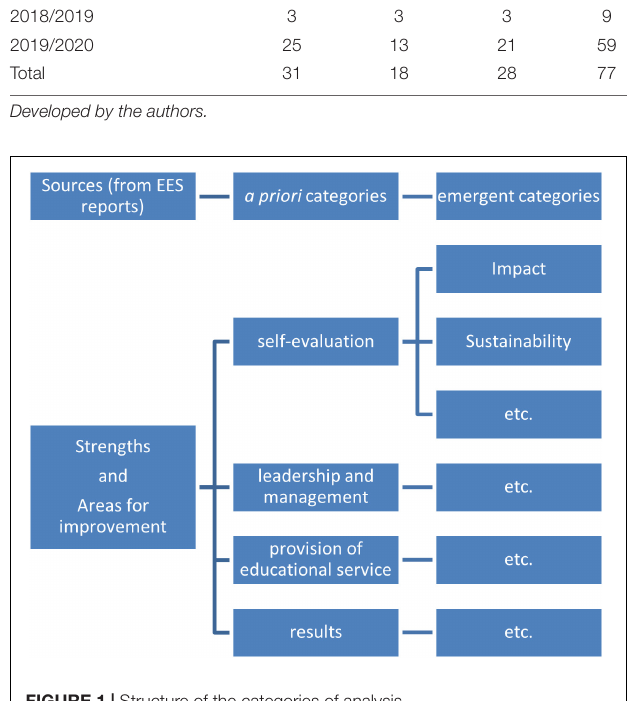
FIGURE 1 | Structure of the categories of